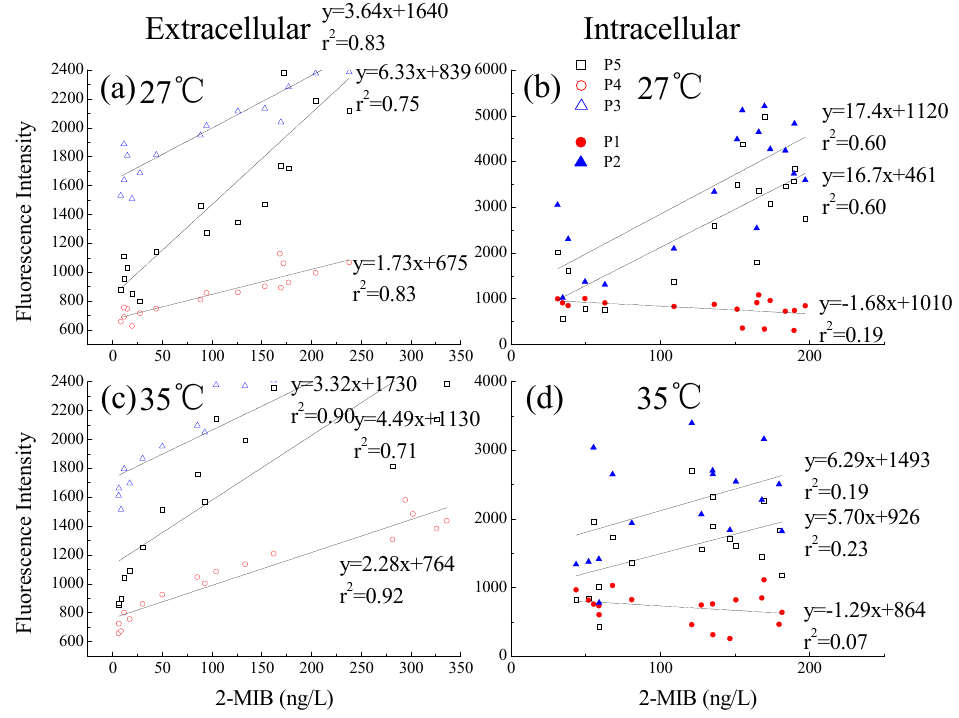
Figure 6. Fitting curves of each DOM’s FI and 2-MIB concentration of Dolichospermum spiroides . ( a ) Extracellular DOM and 2-MIB at 27 °C; ( b ) Intracellular DOM and 2-MIB at 27 °C; ( c ) Extracellular DOM and 2-MIB at 35 °C; ( d ) Intracellular DOM and 2-MIB at 35 °C.